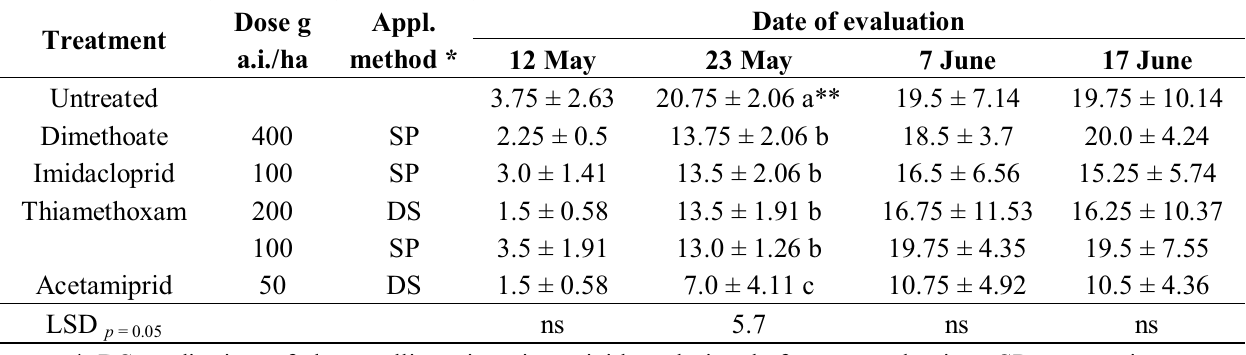
Table 6. Experimental results determined on the basis of visual survey of plants and observing percent of plants showing symptoms of Delia radicum (L.) larval infestation (±SEM) in 2008 following treatment with various insecticides, or untreated.